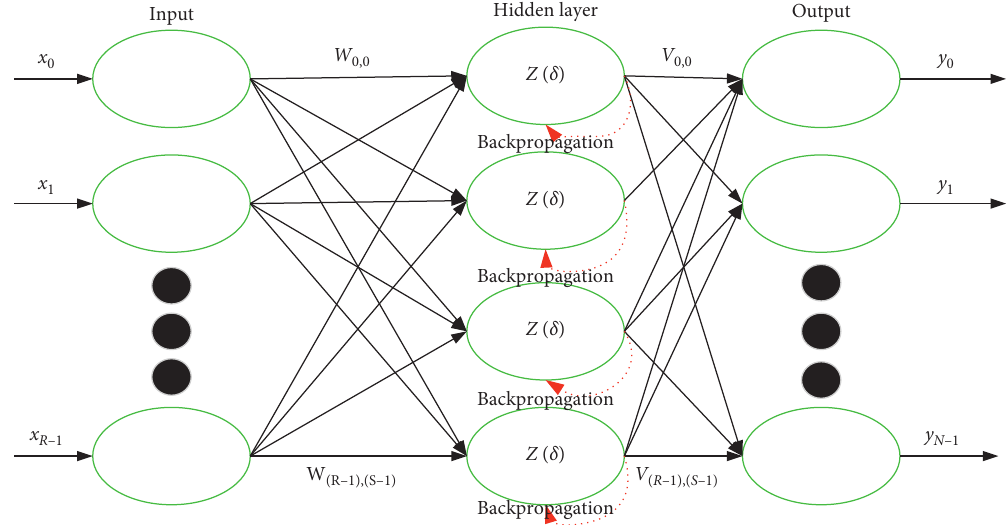
Figure 1: The topological structure of the BP neural